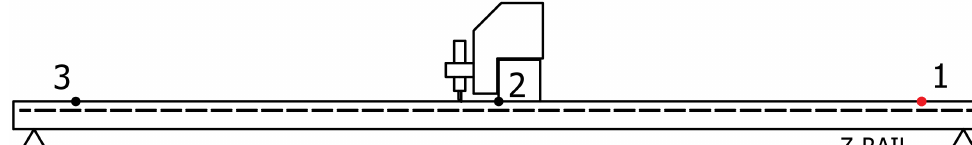
Figure 6. Measurement points on Z-rail, with the red one corresponding to excitation.